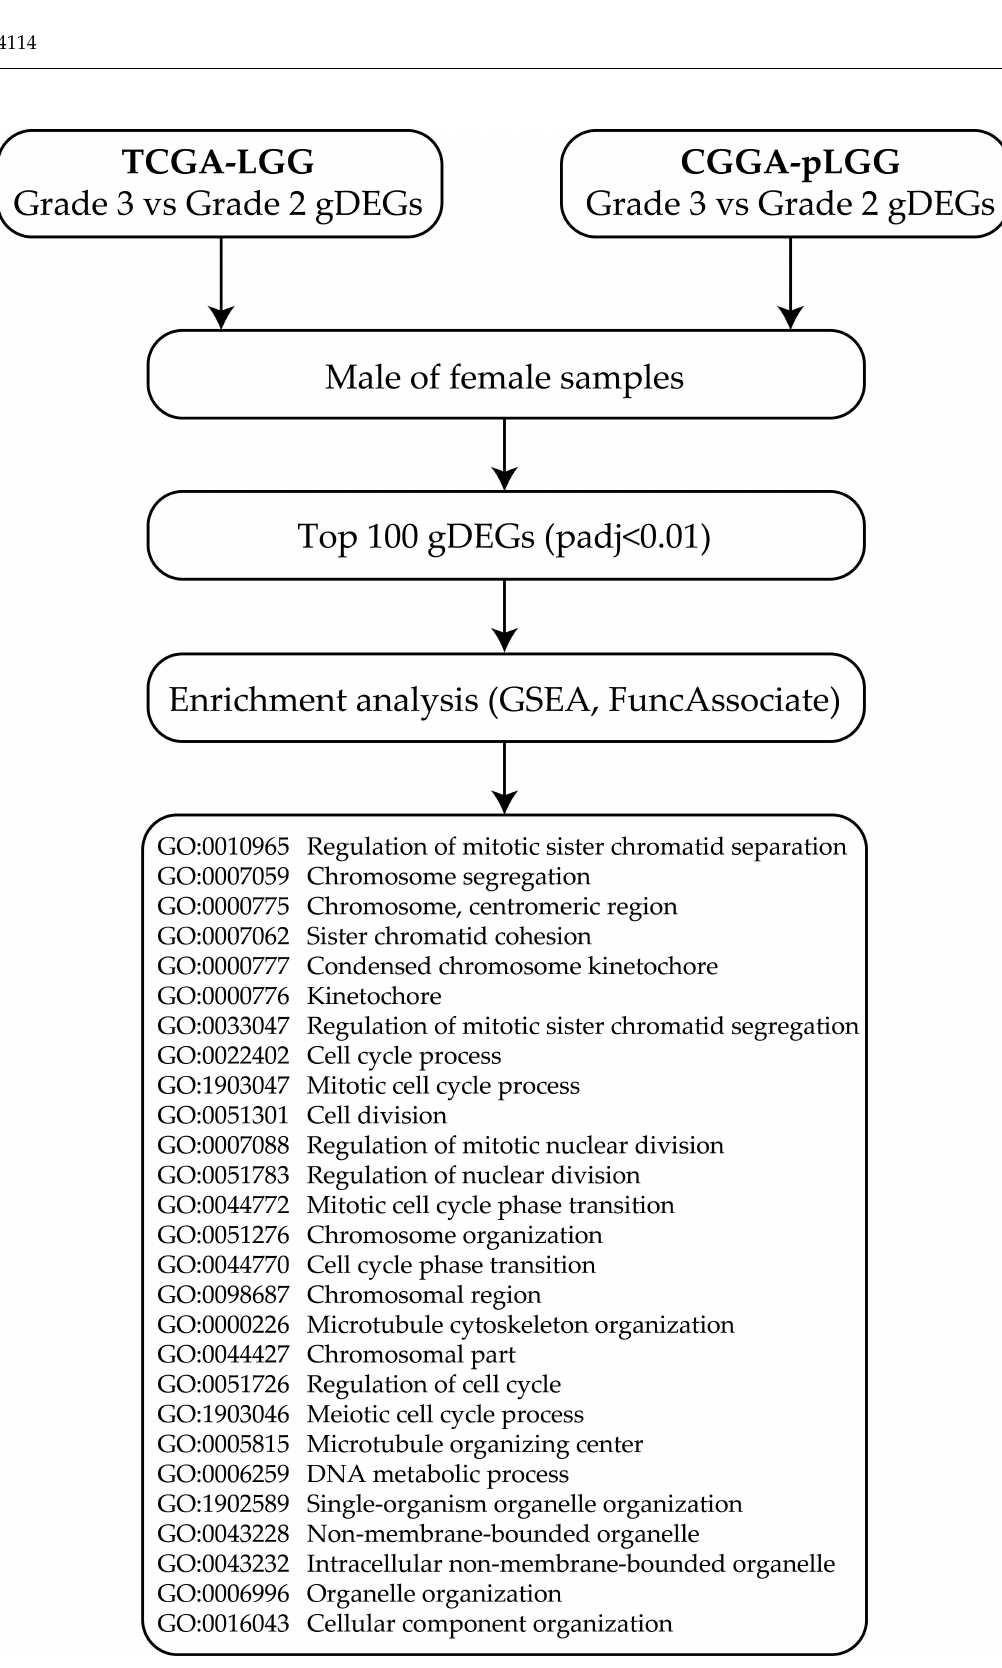
Figure 1. Workflow for the selection and analysis of grade 3 over grade 2 differentially expressed genes (gDEGs) from either male or female glioma samples collected from the TCGA or CGGA databases. Once identified, top 100 gDEGs were submitted to functional enrichment analysis using GSEA or FuncAssociate pipelines. GO terms common to the lists extracted from TCGA and CGGA are